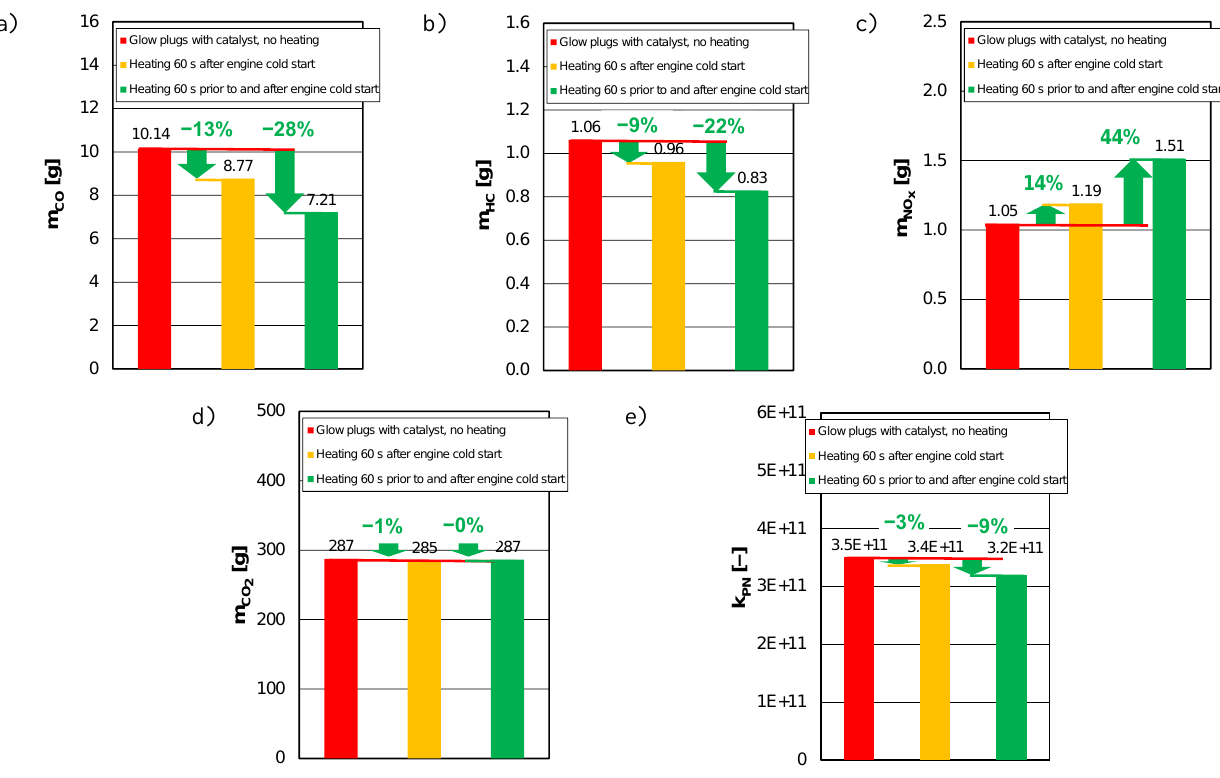
Fig. 8. Comparison of the emission of carbon monoxide (a), hydrocarbons (b), nitrogen oxides (c), carbon dioxide (d) and particle number (e) during the tests performed on a diesel engine depending on the catalyst-coated glow plug heating